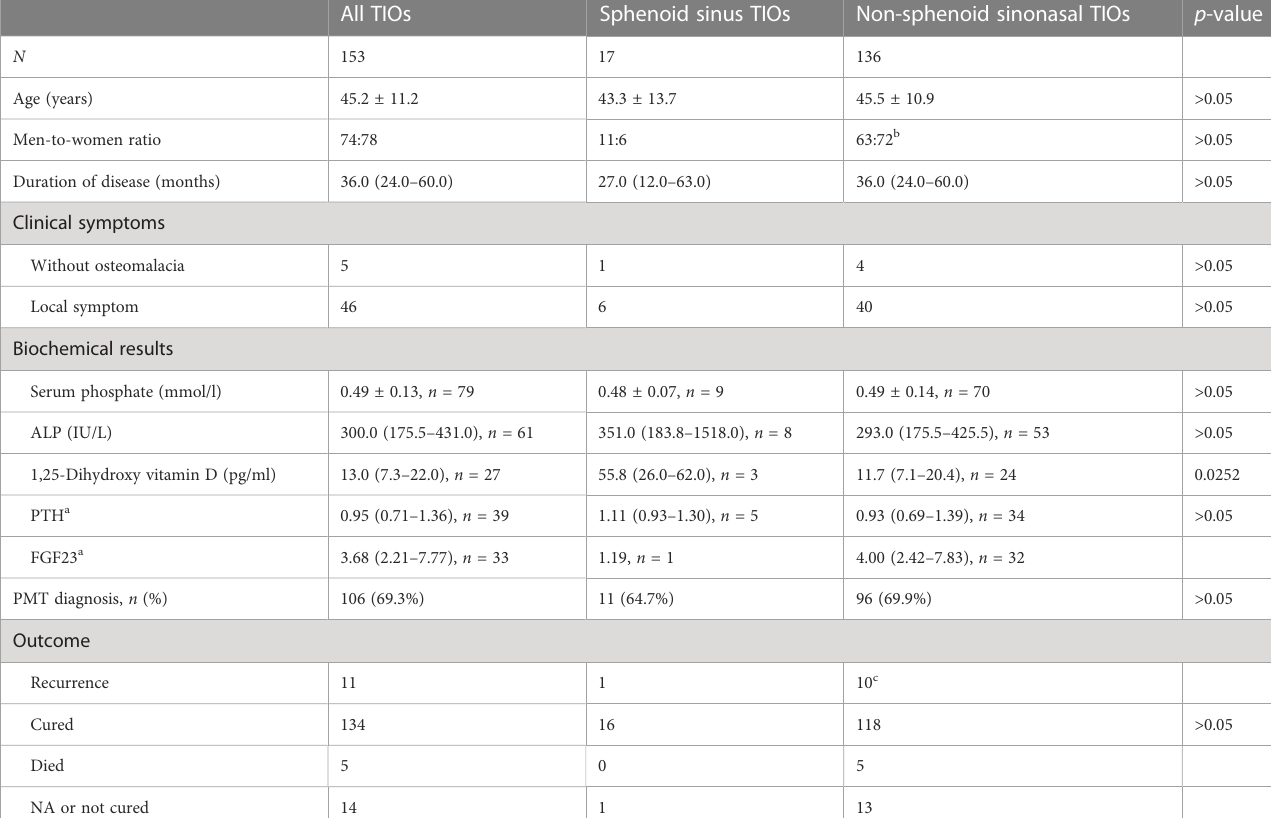
TABLE 2 Clinical features of the different groups.